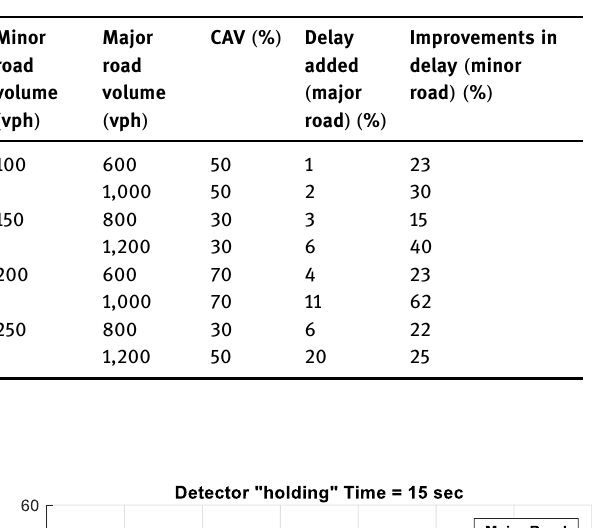
Table 1: Comparison of delays due to gap creation by CAVs